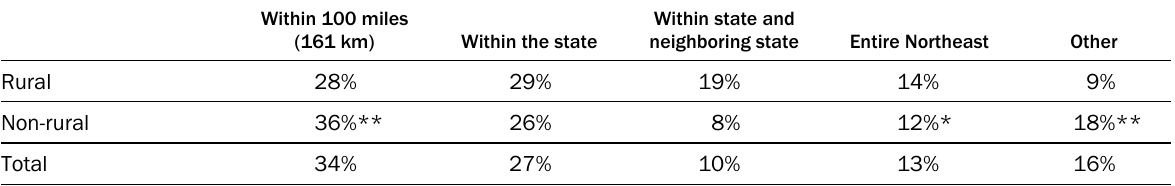
Table 1. Shopper Preference of From Where Food is